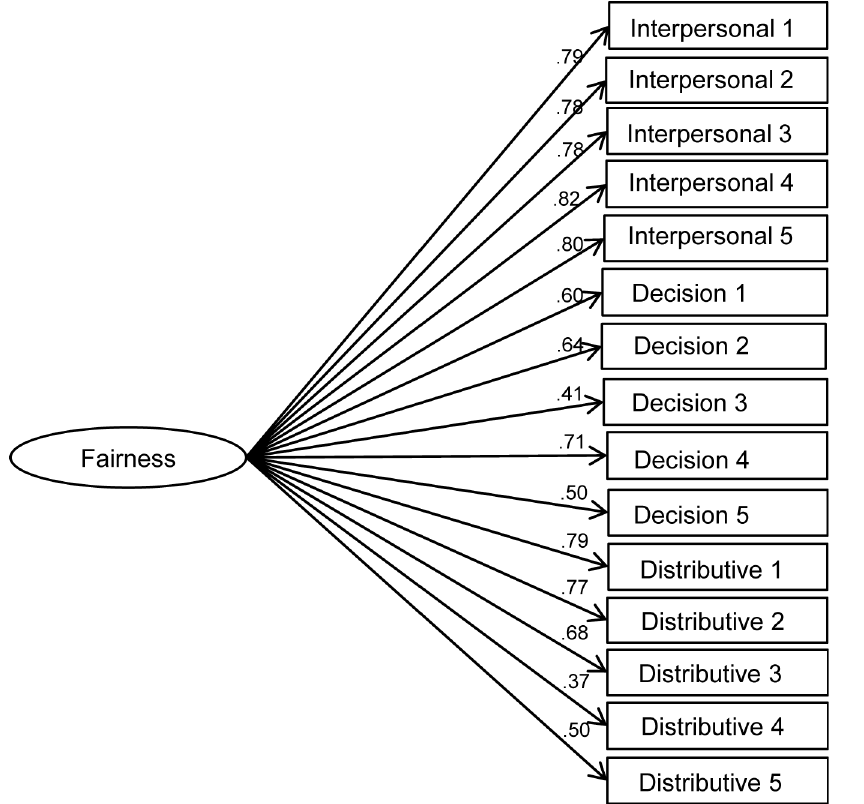
Fig 2. One-factor model of police fairness measures(general fairness; model